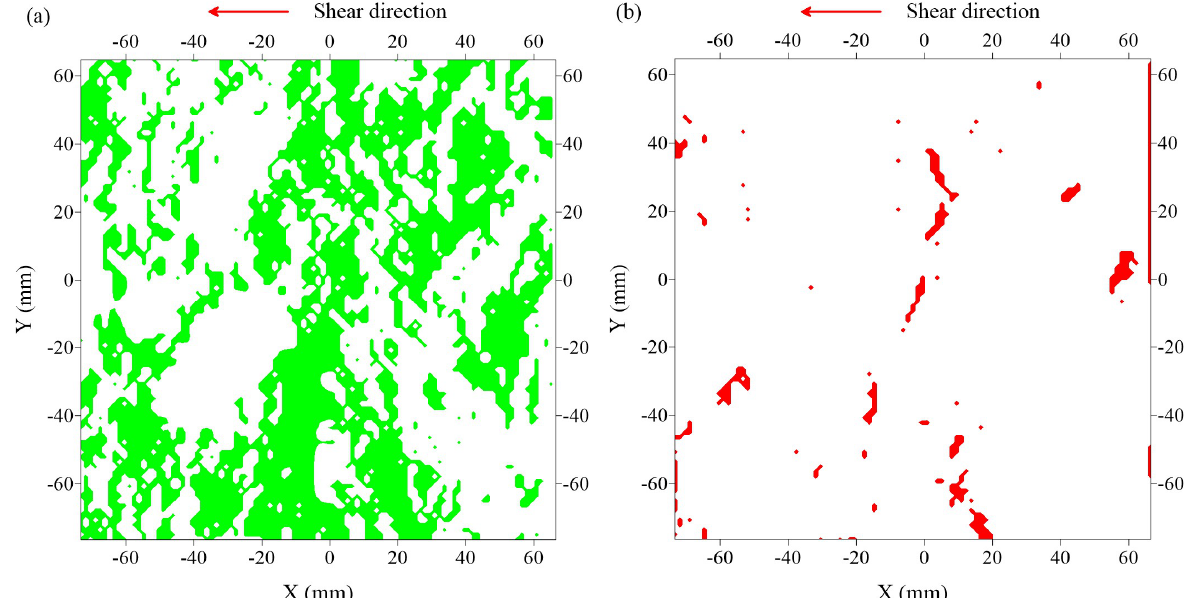
Figure 17. Two types of failure areas for shearing in the negative direction of the x axis. ( a ) Dilatancy failure area; ( b ) Fracture failure area.